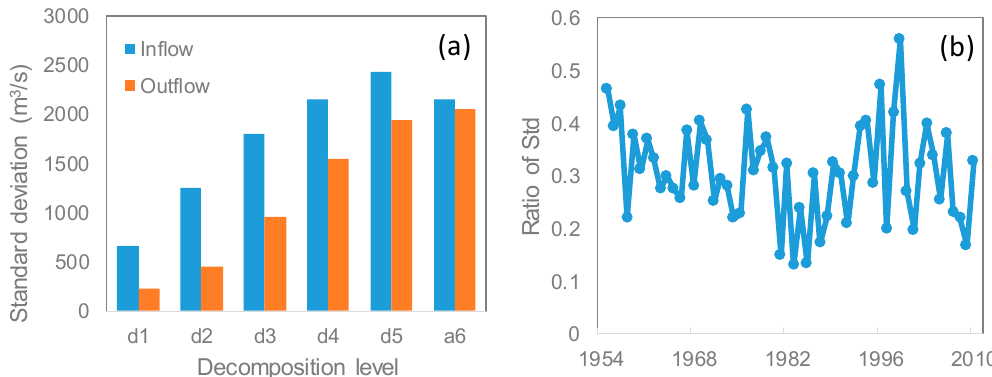
Figure 3. Comparison of the standard deviation (Std) of the wavelet decomposition between inflows and outflows ( a ), and the removing ratios of the Std for medium- to small-scale flood ( b ).